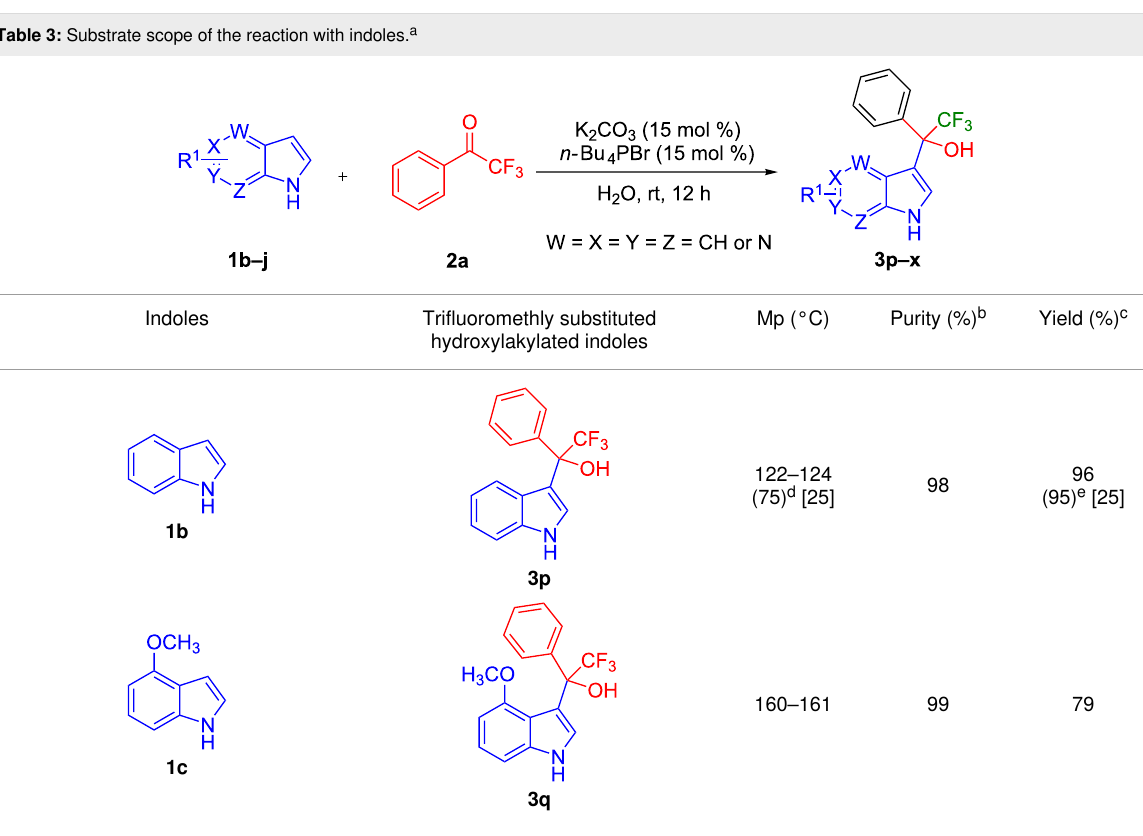
Table 3: Substrate scope of the reaction with indoles.